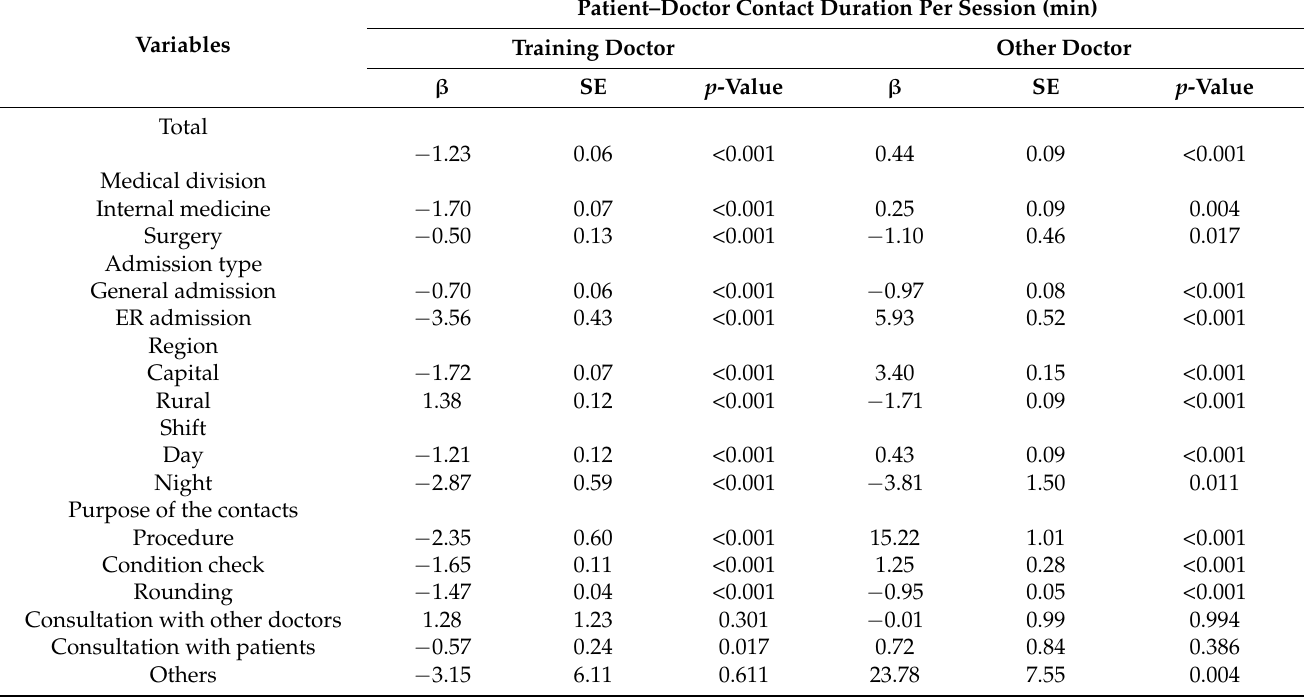
Table 3. Regression results of patient–doctor contact duration per session